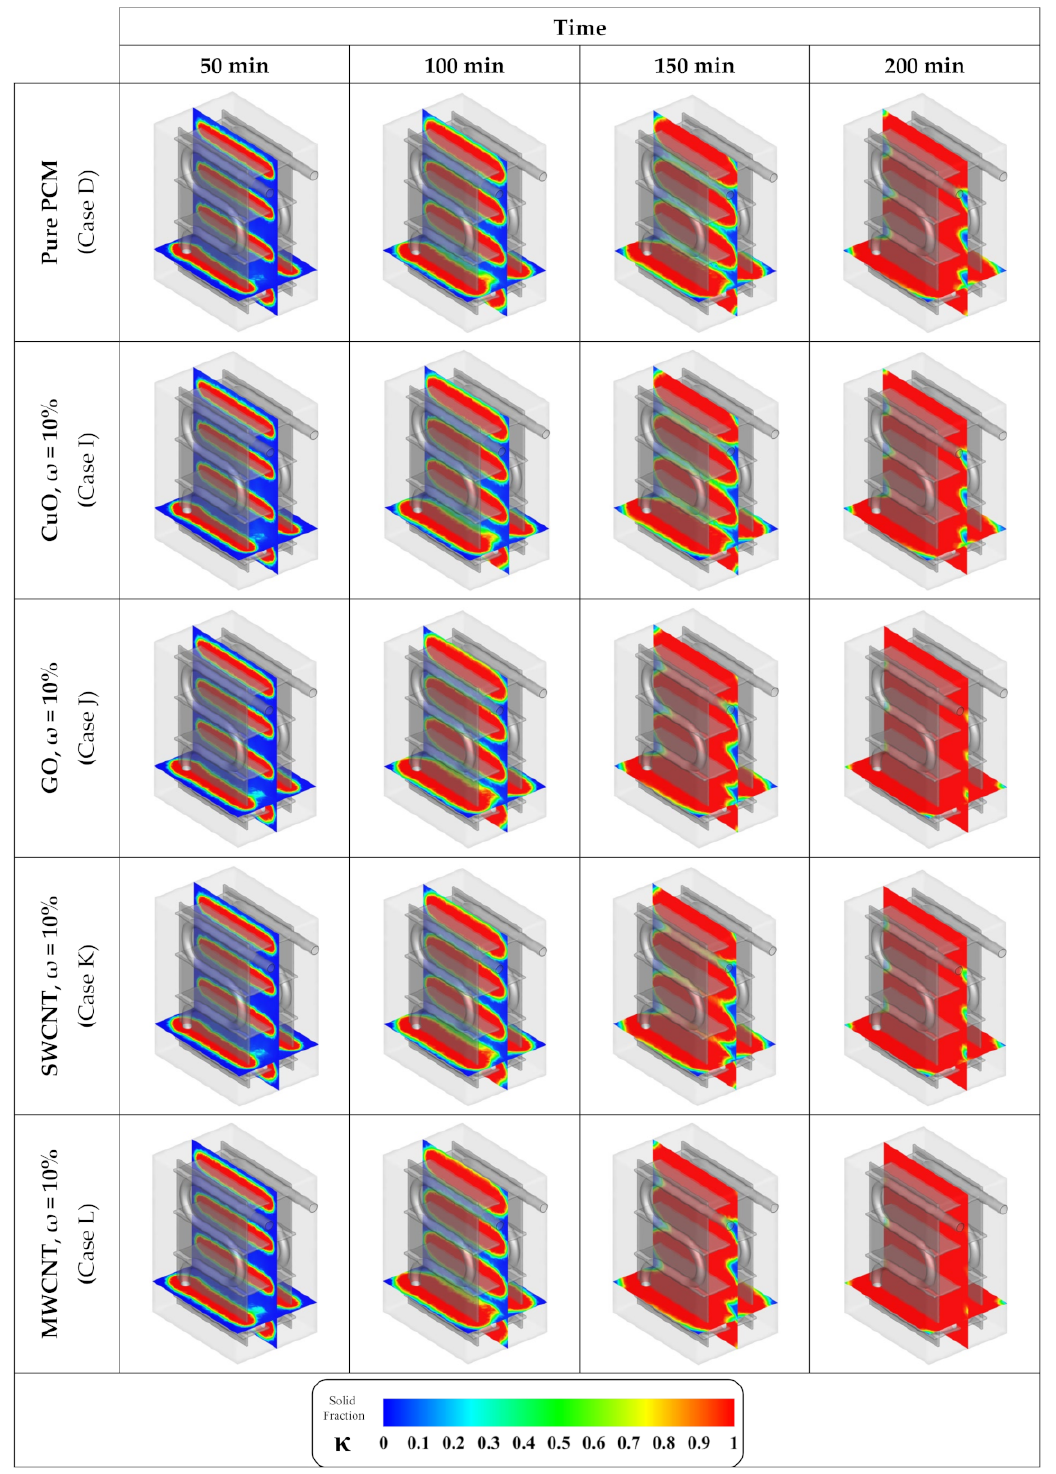
Figure 10. Contours of solid fraction advancement with various NM types at identical mass fractions ( ω =